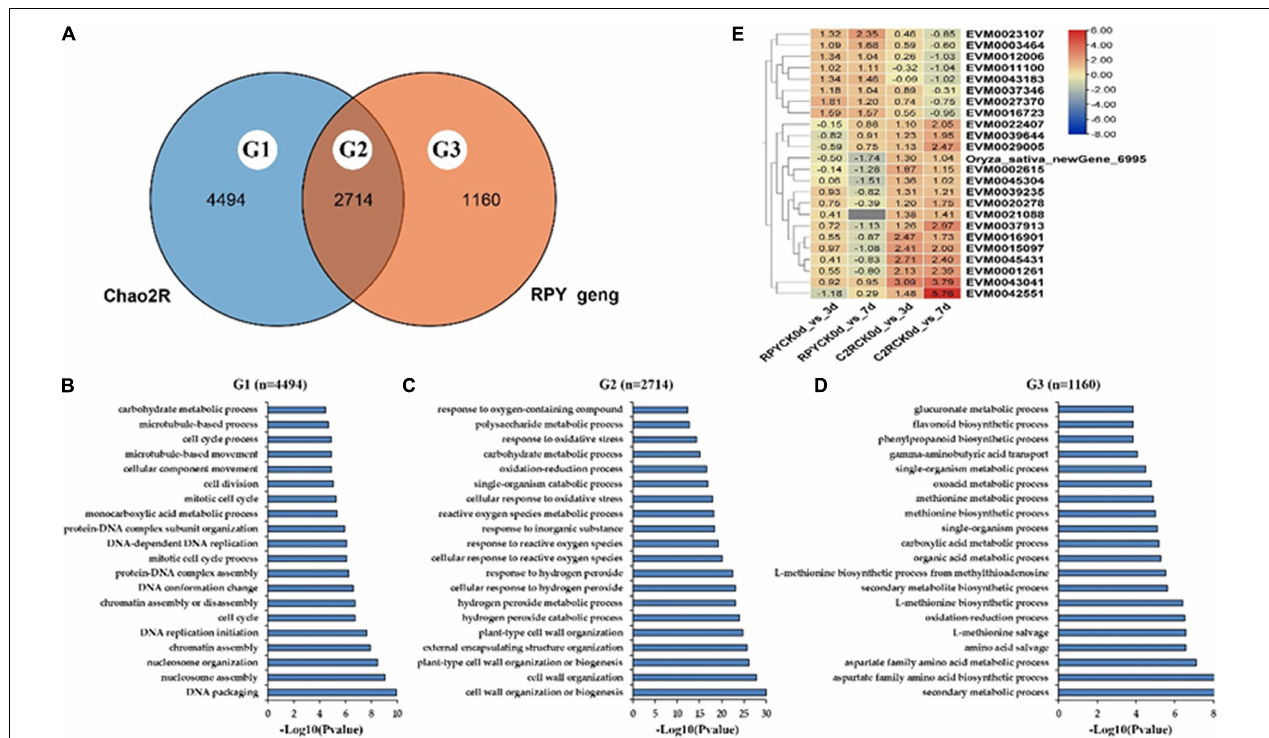
FIGURE 3 | Go annotation and heatmap of DEGs. (A) Venn analysis of all DEGs between Chao 2R and RPY geng. (B) Top 20 Gene ontology (GO) terms of Chao-2R specific DEGs. (C) Top 20 GO terms of common DEGs in Chao 2R and RPY geng. (D) Top 20 GO terms of RPY geng specific DEGs. (E) Heatmap of DEGs with the opposite expressed profiles in two subspecies. RPY means RPY geng, C2R means Chao 2R, 0d, 3d, and 7d means control, 3rd day after treatment, and 7th day after treatment in panel (B)